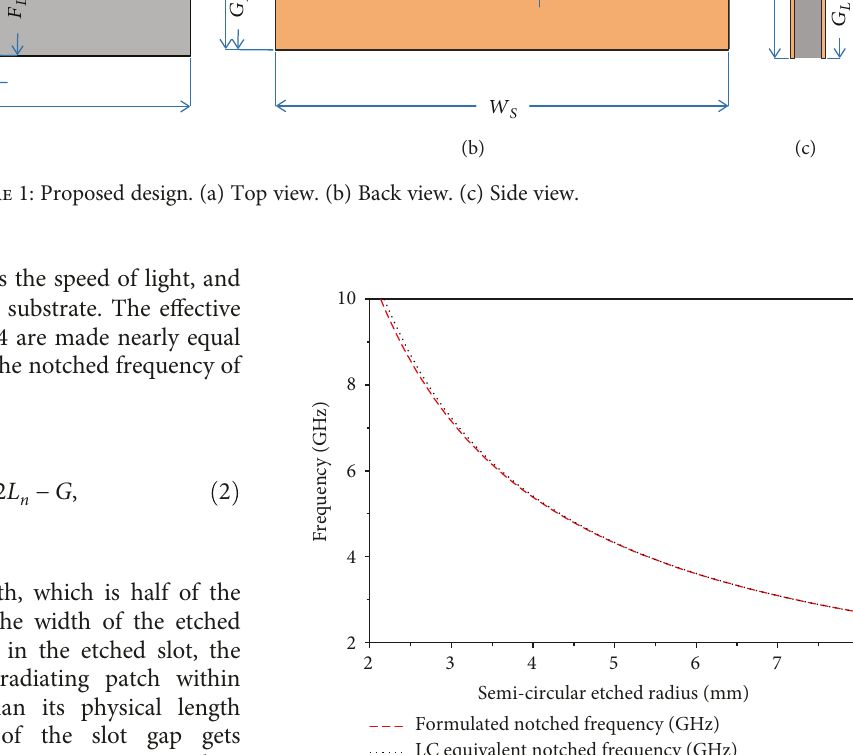
) vs. LC equivalent ( f ) notched n 0